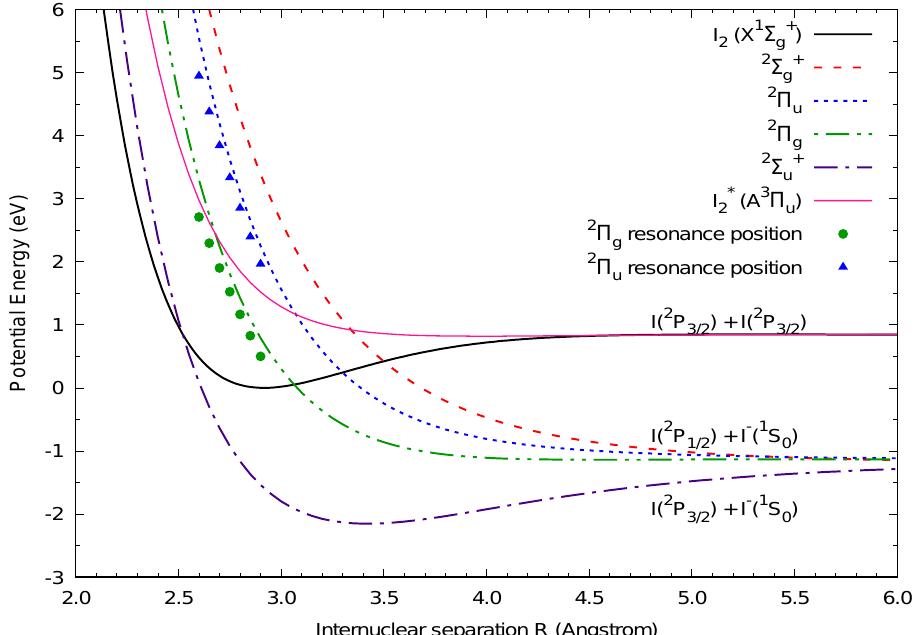
Figure 3. Ab initio calculations of the neutral and anion (resonance) potential energy curves. MOLPRO results are shown for the four resonant symmetries 2 Σ + g , 2 Π u , 2 Σ + u , and 2 Π g . The 2 Π g and 2 Π u resonance positions calculated with the R -matrix method agree well with the bound-state results.